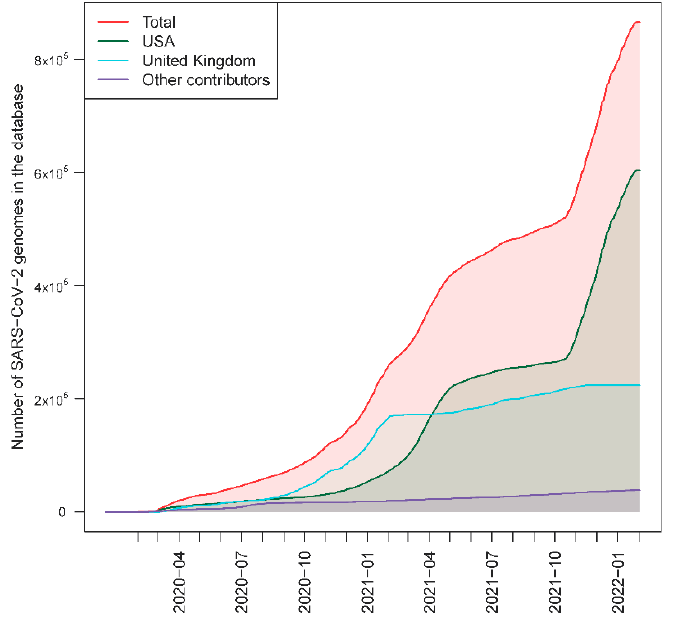
Figure 1. Accumulation of SARS-CoV-2 genomes in the GenBank database over time and the two main contributors, the UK and USA; the rest of the contributors have been grouped in a single